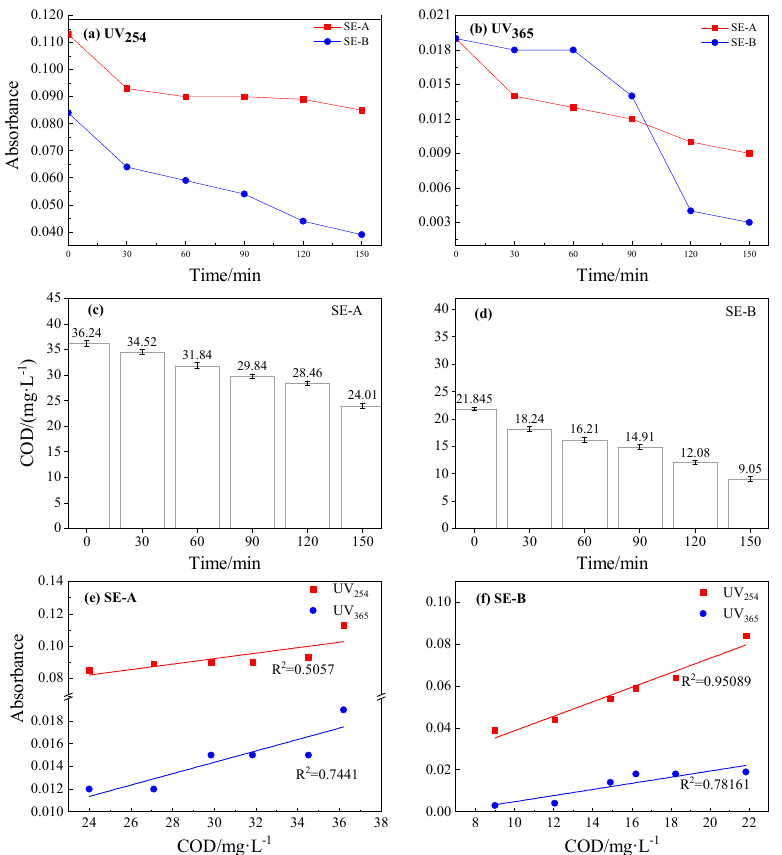
Figure 6. The changes of UV 254 , UV 365 , COD and correlation analysis after photocatalytic degradation in SE-A and SE-B. ( a ) and ( b ) are the decreasing trend of UV 254 and UV 365 . ( c ) and ( d ) are the content of COD after photocatalytic degradation in SE-A and SE-B, respectively. ( e ) and ( f ) reveal the correlation between COD and UV 254 and UV 365 in SE-A and SE-B.